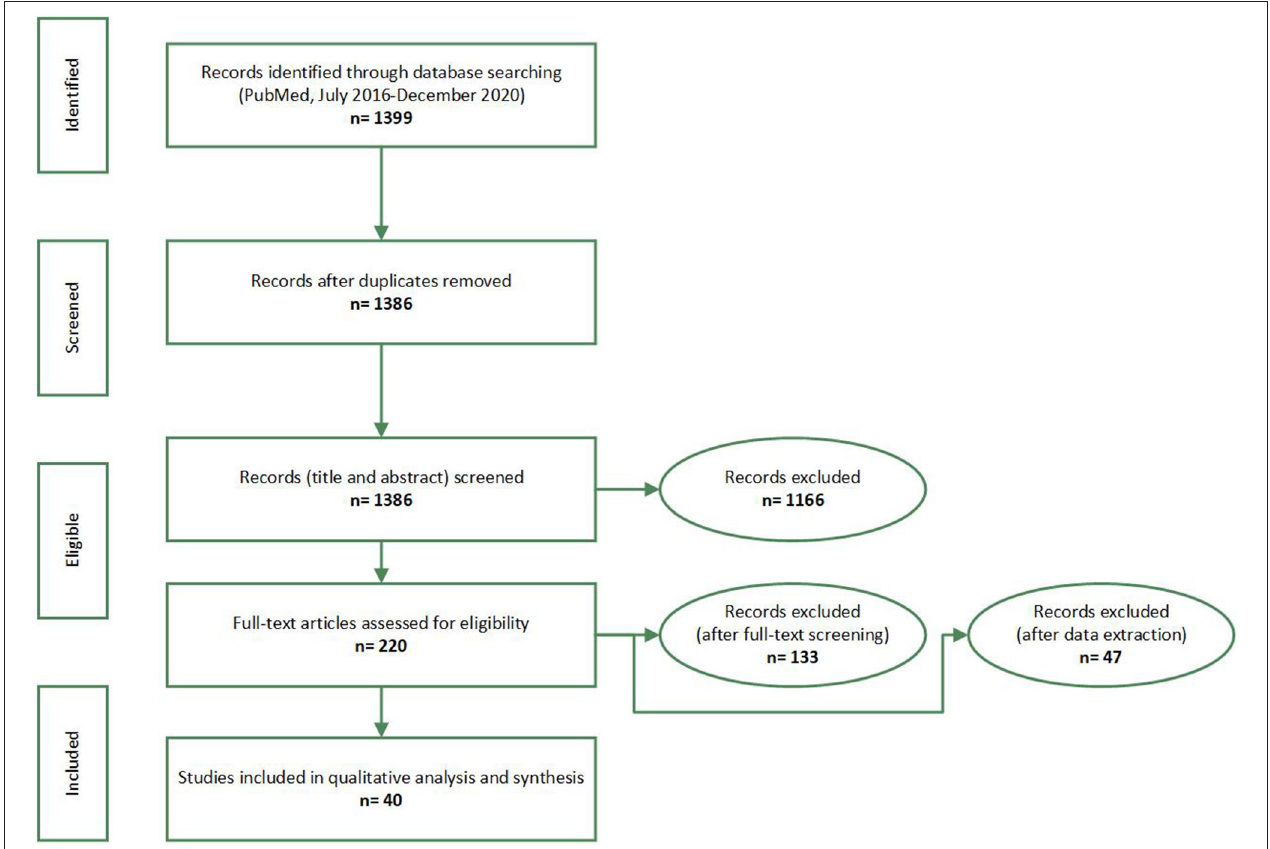
FIGURE 1 | PRISMA flow-diagram. Promoting university students’ mental health: a systematic literature review introducing the 4M-Model of individual-level interventions, Dubai, United Arab Emirates,